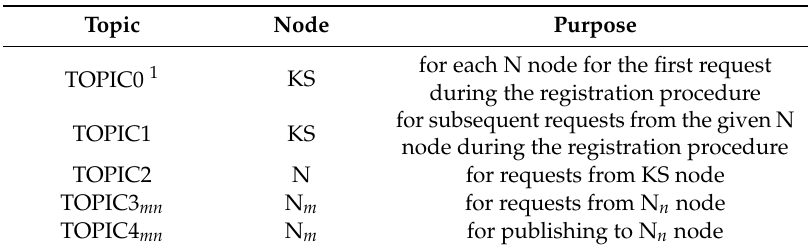
Table 1. List of topics used by the nodes.